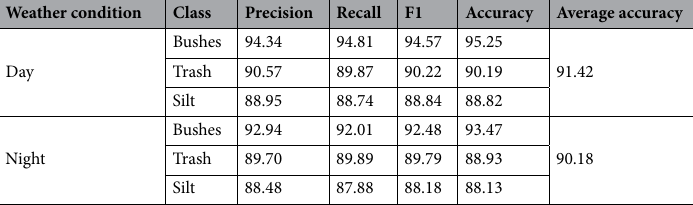
Table 3. Statistical measures results of drain inspection algorithm.